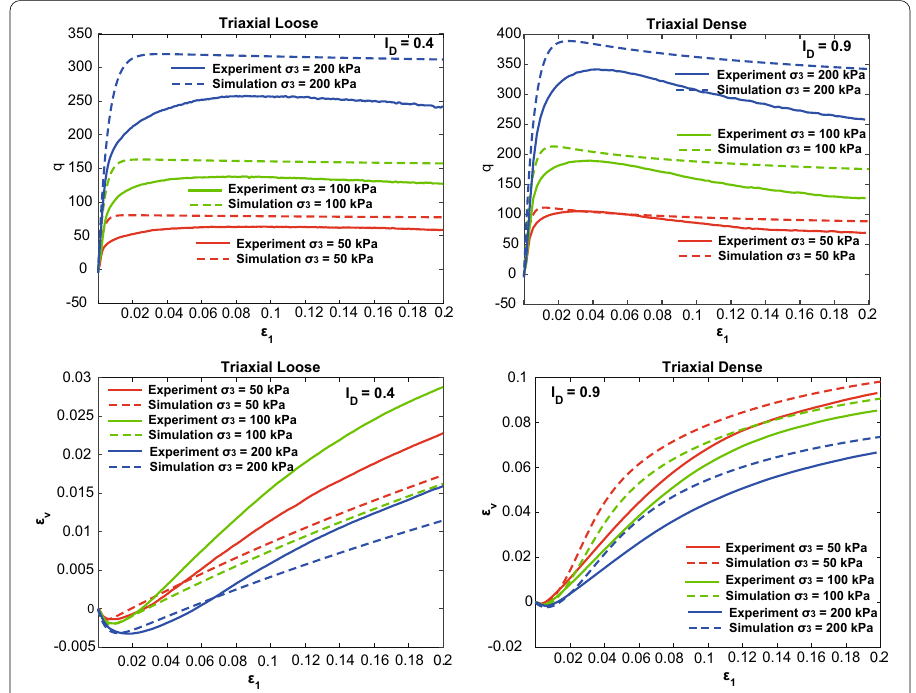
Fig. 6 Prediction of undrained triaxial experimental results by calibrated hypoplastic model with intergranular strain